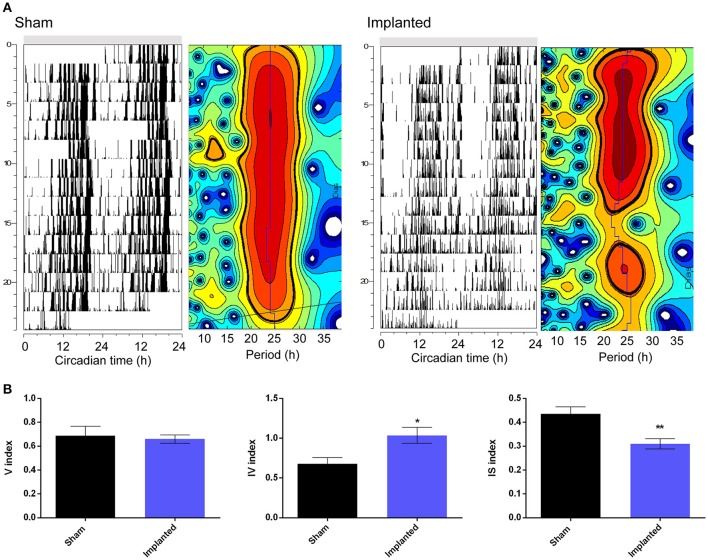
Hypothalamic gliomas affect endogenous period stability. (A) Representative actograms and their corresponding instantaneous period calculation of control (sham) and implanted animals in constant darkness conditions. For instant periods, heatmaps plots refer to the significance of the endogenous period calculated by wavelet analysis. The vertical axis represent the successive days of activity, with the same scale of the corresponding actograms. The horizontal axis indicates the period in hours. The blue line shows the period of maximum significance across days. Black lines delimitate periods that are statistically significant (Torrence and Compo, 1998). (B) Tumor-implanted animals showed higher fragmentation of locomotor activity rhythms, as well as less strength of coupling of the activity to the τ that best describes the rhythms, although no effect was found by analysis of τ variability through wavelet-based computations (described by IV, IS, and V indexes, respectively; Student's t-test, *p < 0.05 for IV, **p < 0.01 for IS and p > 0.05 for V indexes, n = 6 for control and n = 9 for implanted animals).